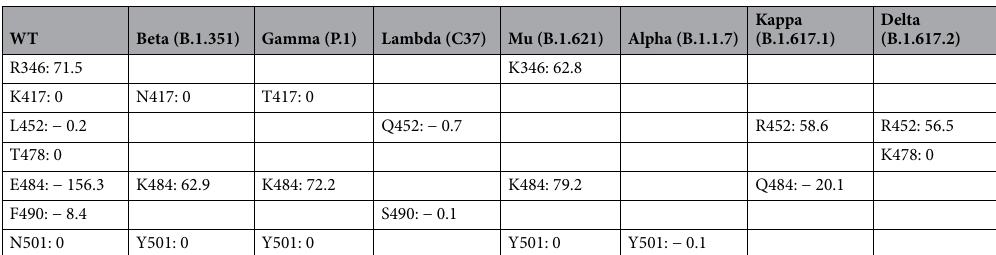
WT Beta (B.1.351) Gamma (P.1) Lambda (C37) Mu (B.1.621) Alpha (B.1.1.7)